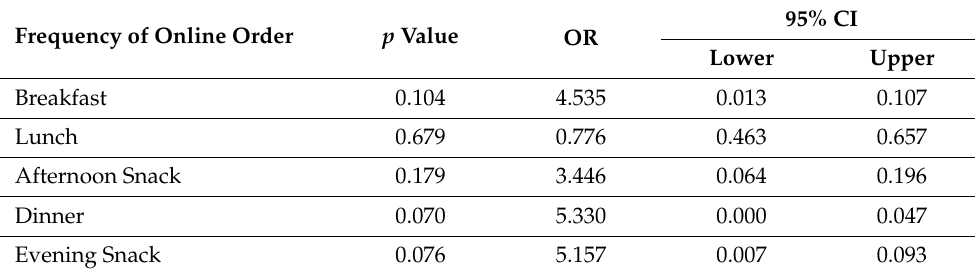
Table 11. Association between health beliefs and frequency of online